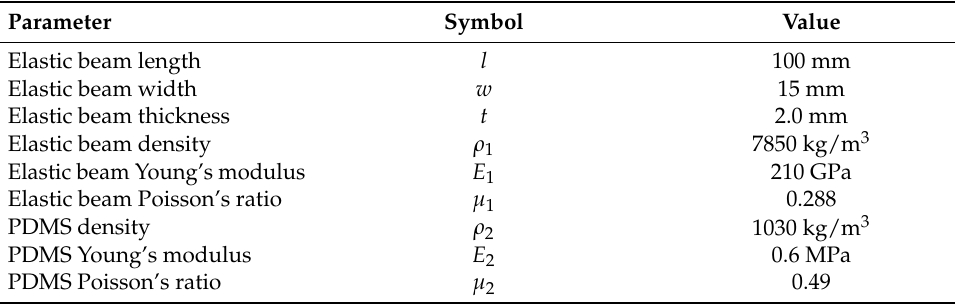
Table 1. Parameters of the piezoelectric resonator and the check